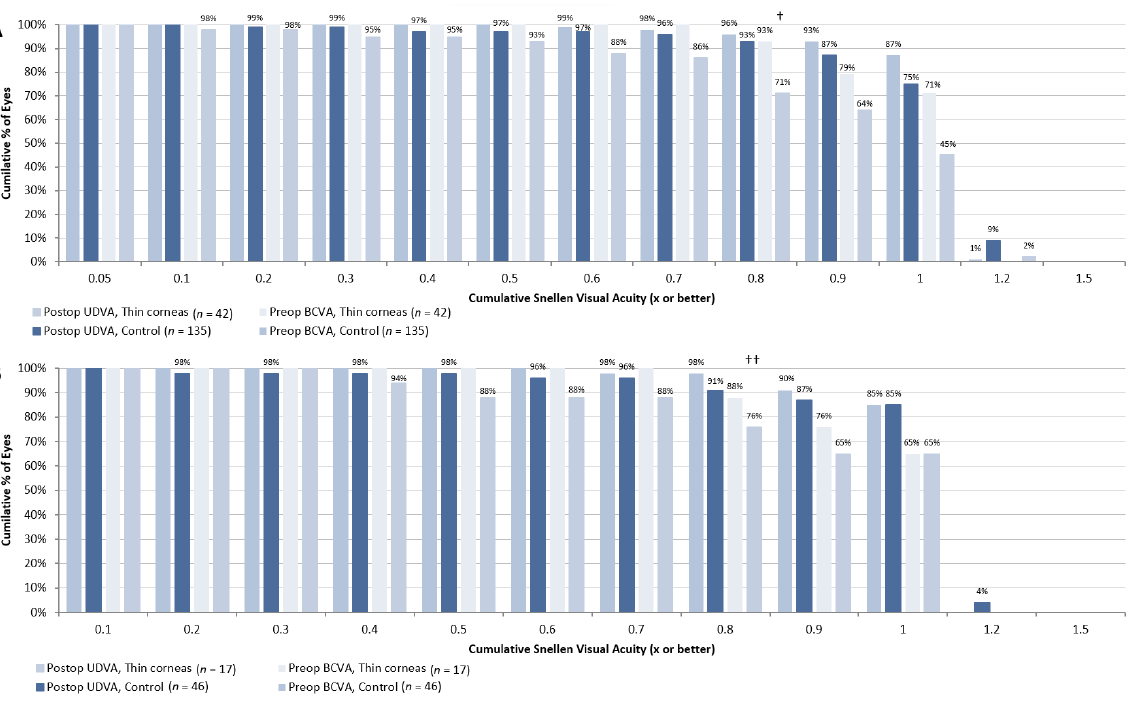
Figure 1. Preoperative corrected distance visual acuity and postoperative uncorrected distance visual acuity at 1 ( A ) and 6 ( B ) months postop. Notes: n —number of eyes in each group for